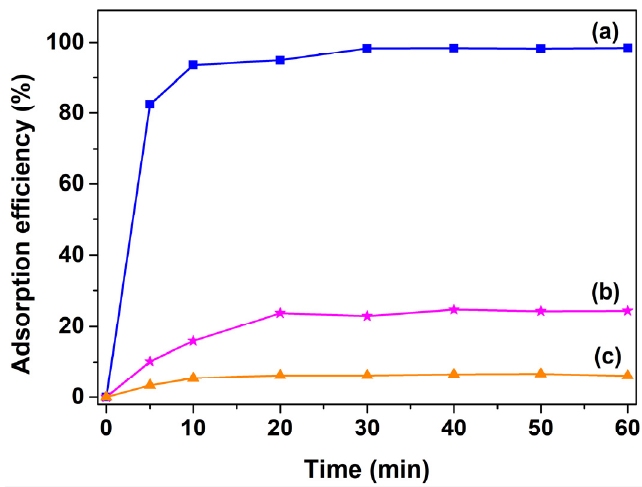
Figure 3. Time–dependence of adsorption profiles of (a) XO; (b) BO2; and (c) AO7 dyes with the presence of superparamagnetic Fe 3 O 4 powders. ([Fe 3 O 4 ] = 1.0 g/L; [dye] = 10 mg/L; Room temperature; without pH preadjustment).